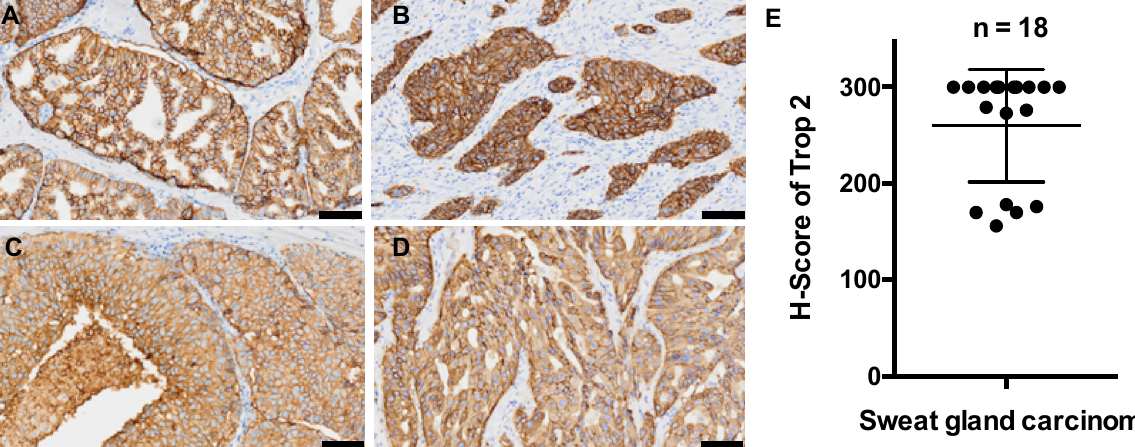
Figure 3. Histopathological images of trophoblast cell surface antigen 2 (TROP2) staining in sweat gland carcinoma. ( A , B ) Strongly positive staining (3+) in primary lesions. ( C , D ) Strongly positive staining (3+) in lymph node metastases. Positive TROP2 signals were found on the membranes and in the cytoplasm of tumor cells. ( E ) The H-scores of TROP2 in all 18 sweat gland carcinoma samples. Bars indicate 100 μ m.